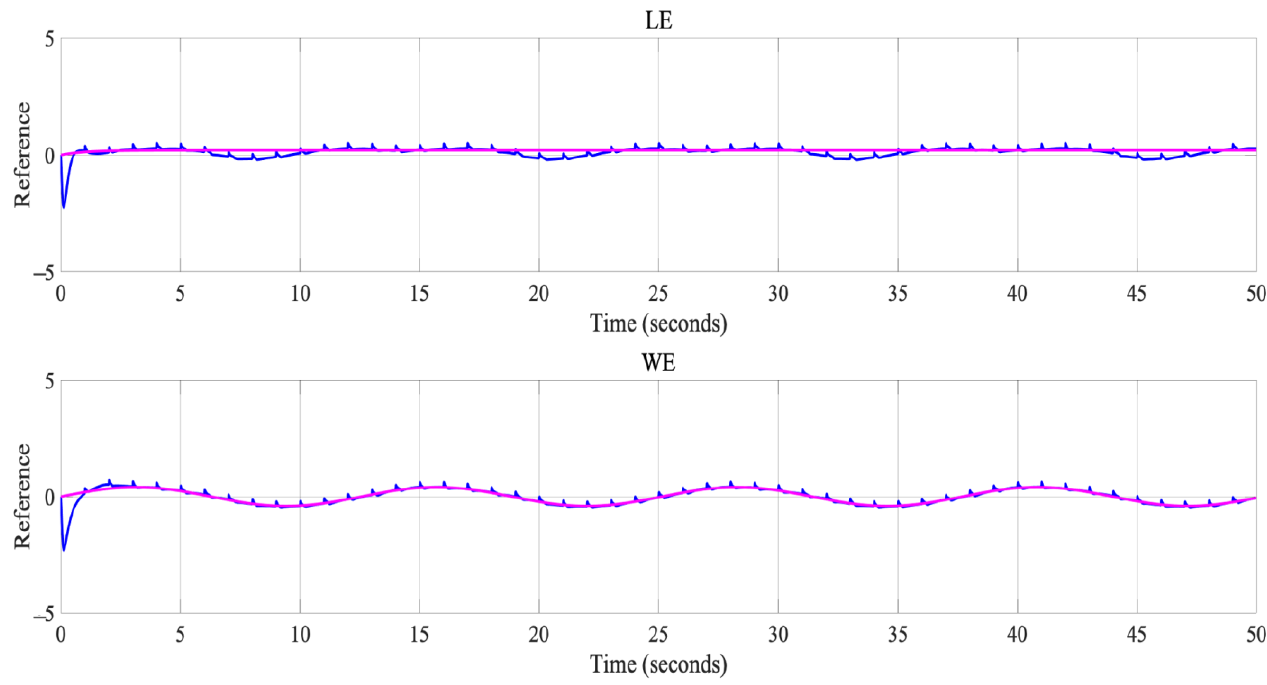
Figure 12. Representation of the best result representing the LE and the WE.